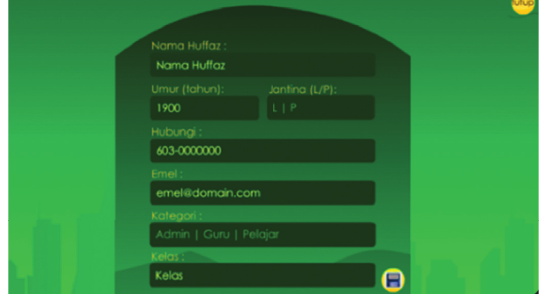
Figure 3: Profile